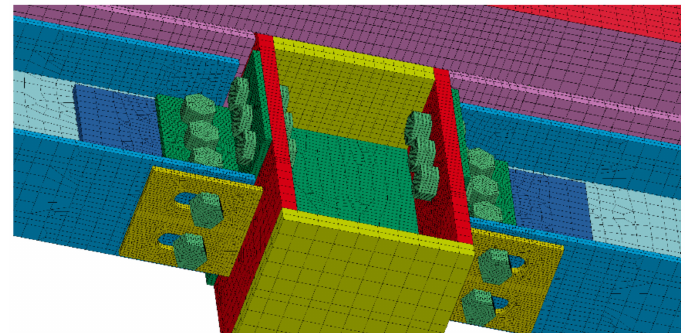
Figure 19. Model M0-RS2: connection region.